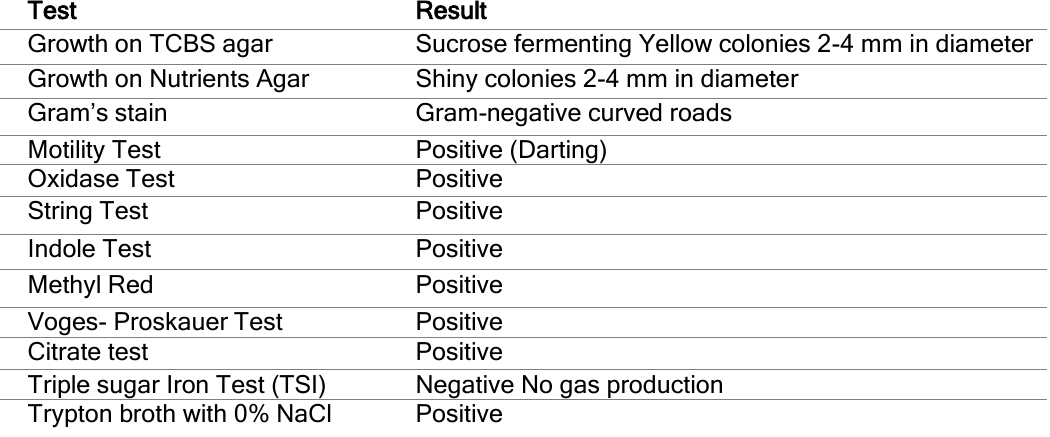
Table 2: Phenotypic Identification of Indigenous V. cholerae